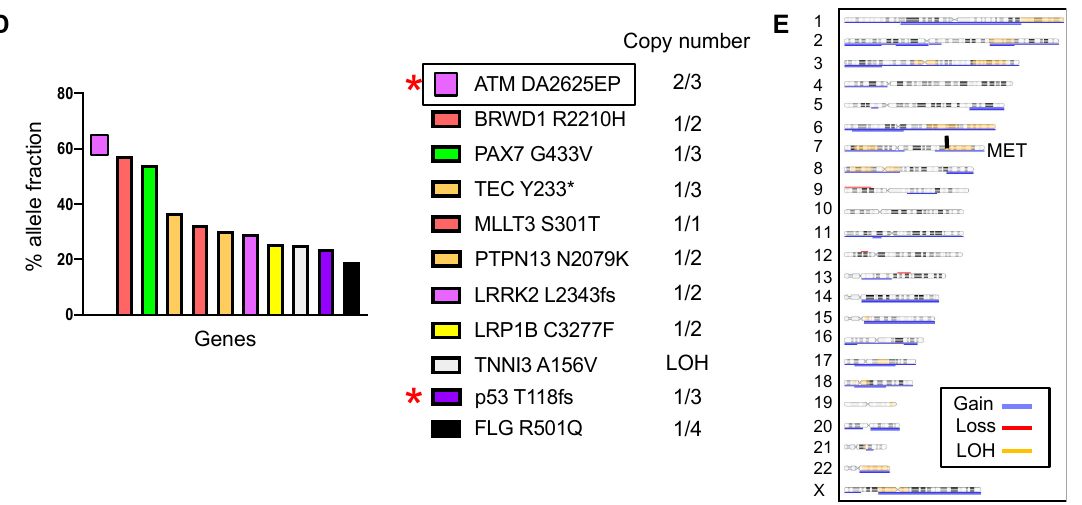
Figure 4. Aggressive course of chordoid meningioma in a young patient with ATM heterozygous germline mutation. ( A ) Time-course of disease. GK, gamma knife radiation. ( B ) Initial tumor: pre-operatory (pre-op) CT and H&E preparation show chordoid meningioma within the bone. NHERF1 IHC reveals microlumens and Ki-67 proliferation is low. ( C ) Re-recurrence: MRI T1W sequence with contrast shows multiple tumors, including re-recurrence of the initial SB tumor. H&E shows sarcomatous transformation with multiple mitotic figures (black arrows) and Ki-67 IHC reveals a high proliferation index. ( D ) Mutation profile of the re-recurrence showing germline ATM mutation (boxed) with copy number gain and miscellaneous somatic mutations, including a pathogenic (red asterisk) TP53 mutation. The copy number for each gene was compiled from the allelic fraction and the chromosomal array. ( E ) Chromosomal array showing multiple gains, LOH regions, and only few losses. The positioning of MET , the only gene showing RNA overexpression is indicated.